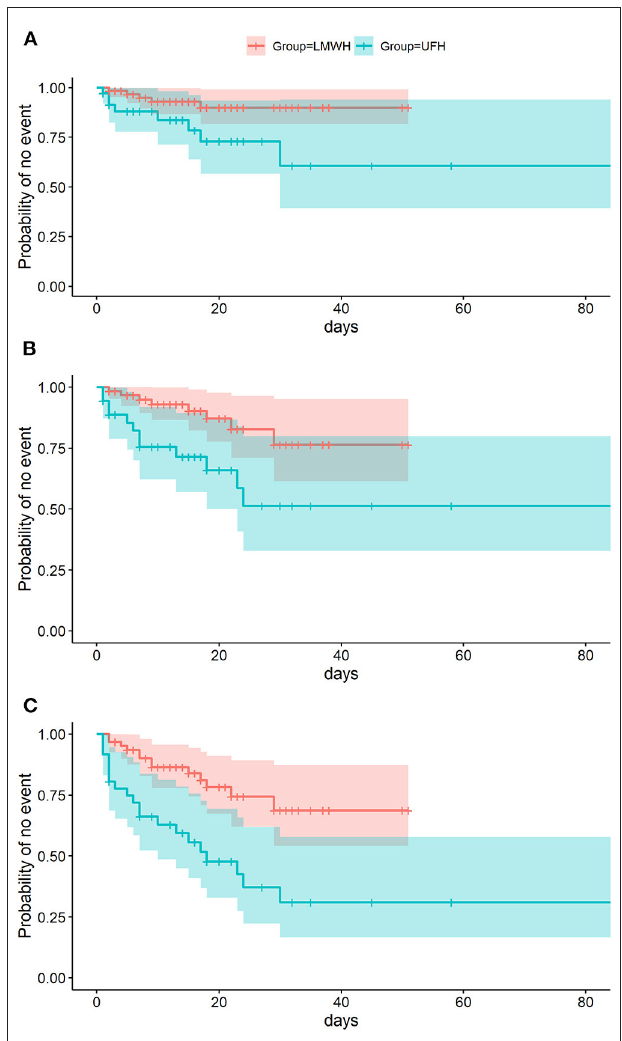
FIGURE 2 | Event-free days during extracorporeal membrane oxygenation. Events that terminated the observation span included (A) thromboembolic endpoint events, (B) hemorrhagic endpoint events, and (C) a composite endpoint made up of both.